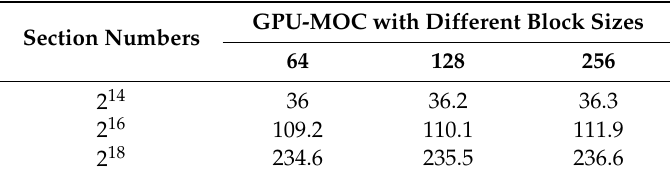
Table 1. Speedup ratios of GPU-MOC to CPU-MOC.